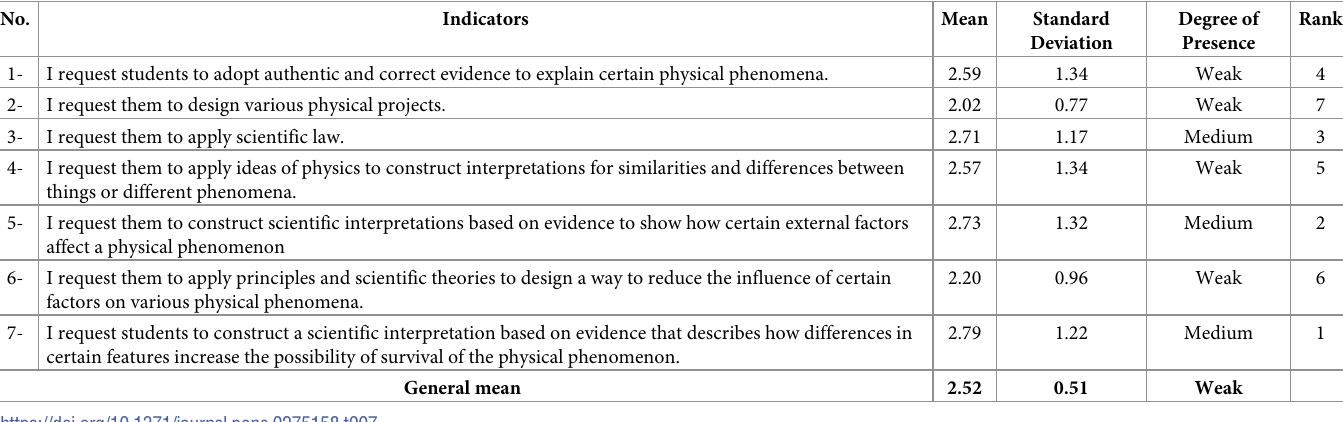
Table 7. The means and standard deviations of the presence of the “constructing interpretations and solution design” practice.